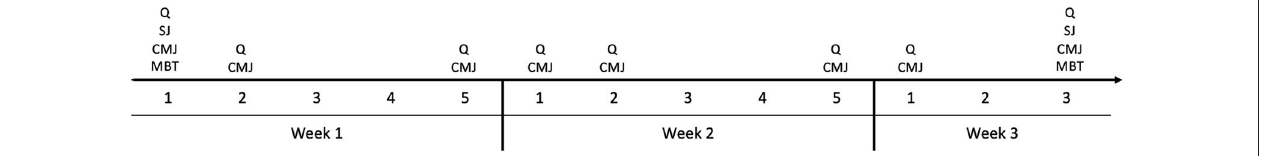
Frontiers in Sports and Active Living |